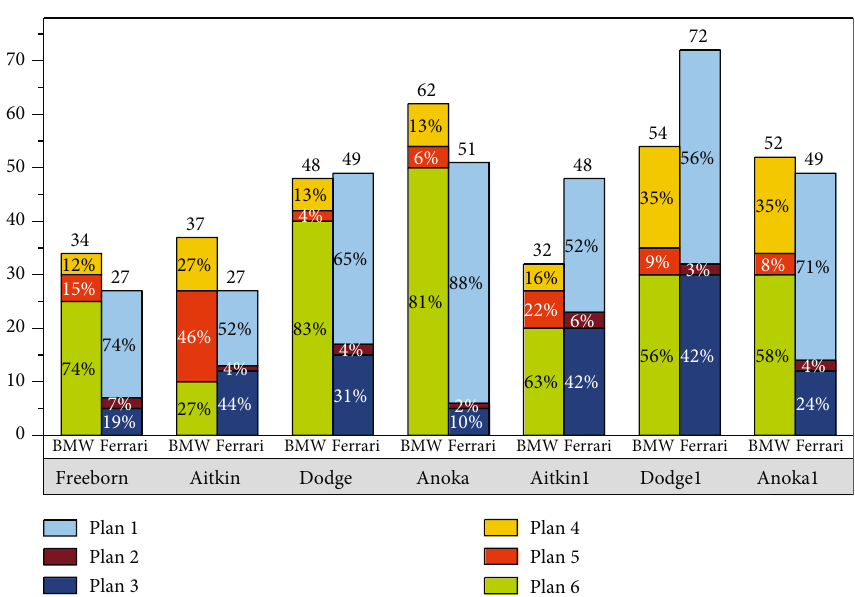
Figure 4: Comparison chart of linguistic